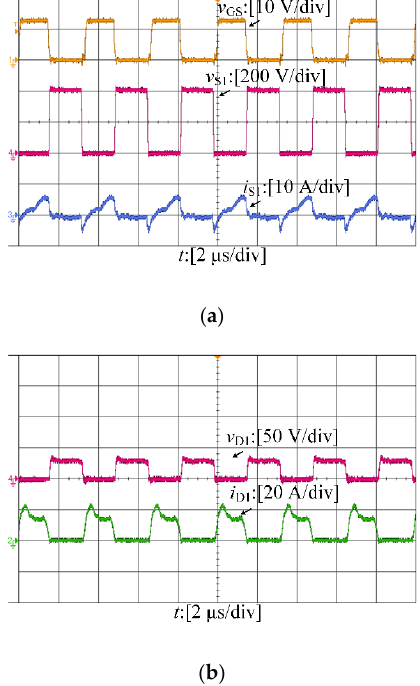
Figure 16. Experimental results at 50% condition ( a ) waveforms of power switch S 1 , ( b ) waveforms of diode D 1 .